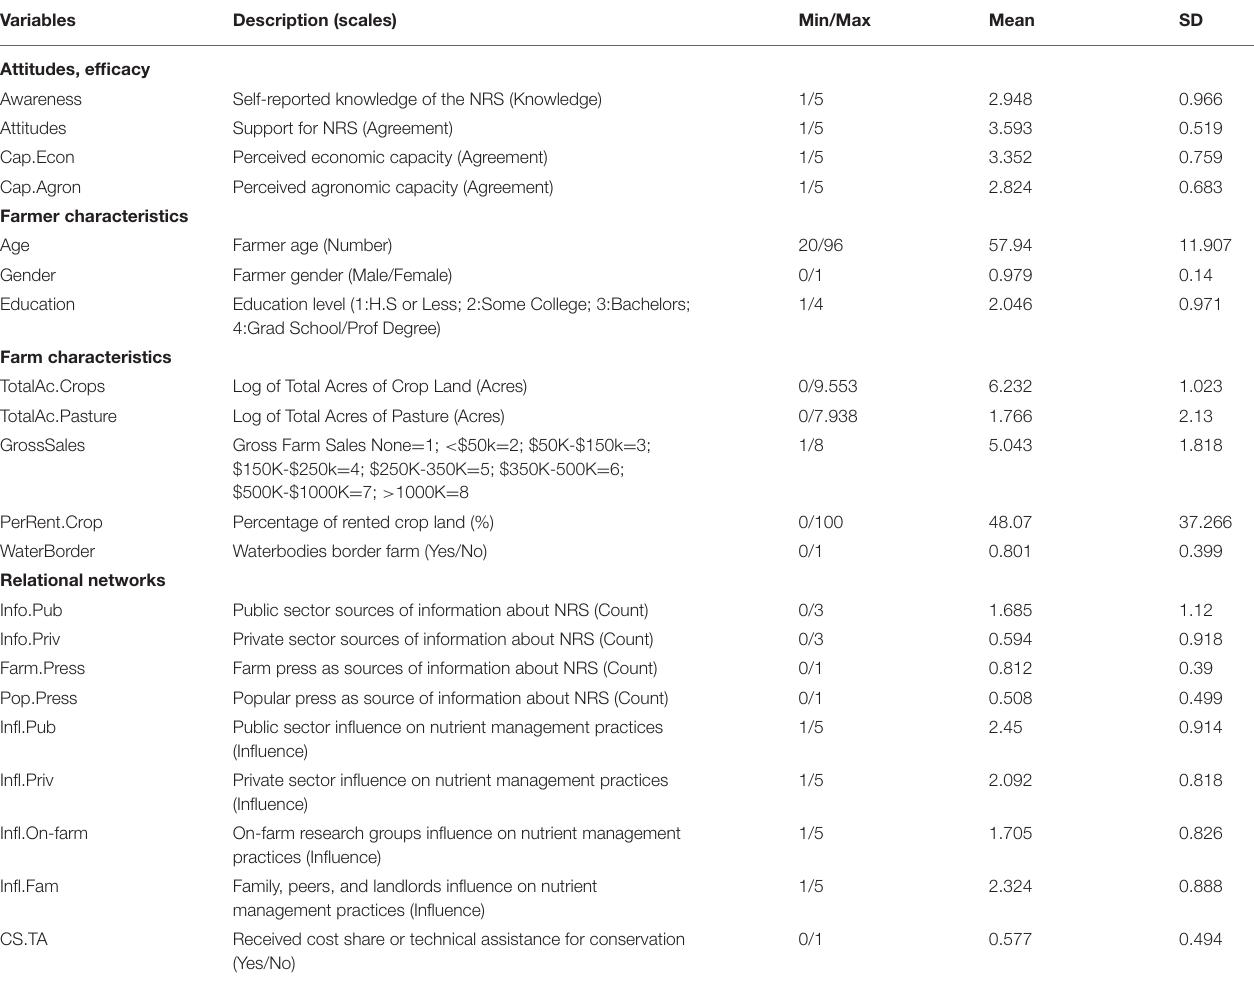
TABLE 3 | Descriptive statistics for the independent variables used in the